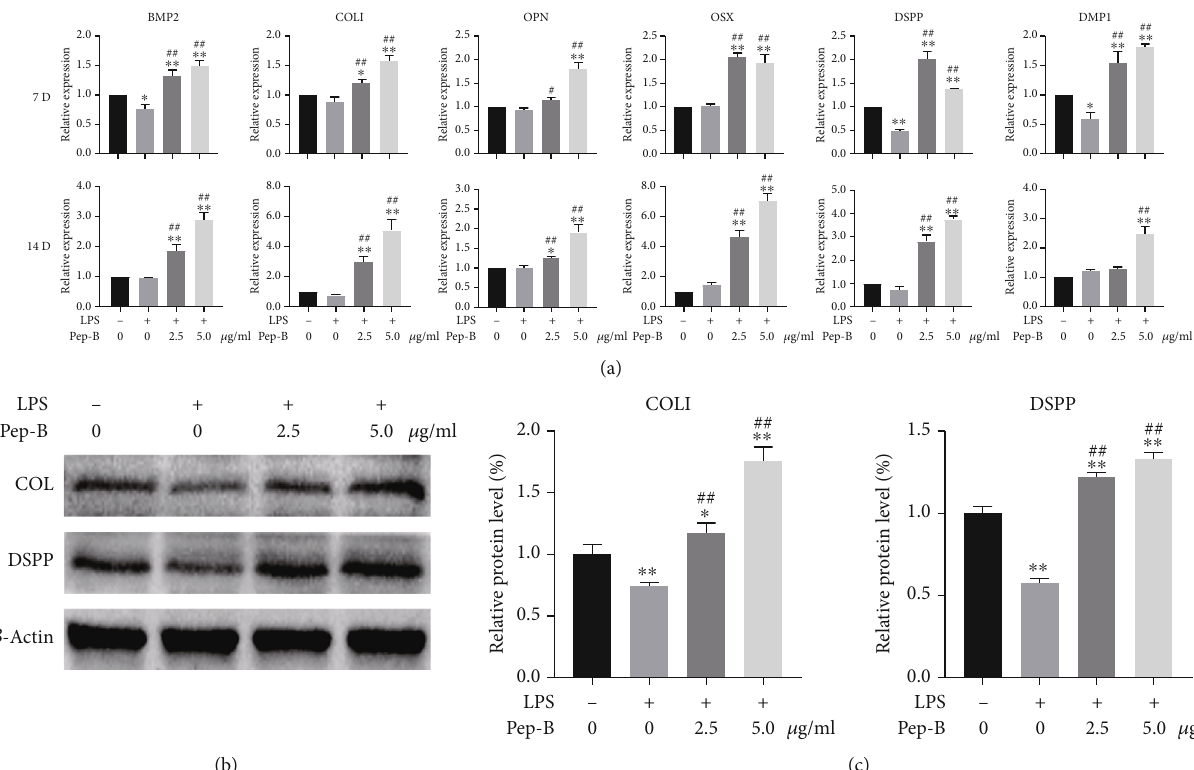
Figure 5: E ff ects of Pep-B on the expression of osteo-/odontoblast genes in LPS-induced hDPSCs. (a) The mRNA expression of BMP2, COL І , OPN, OSX, DSPP, and DMP1 was detected by qRT-PCR at 7 and 14 days. (b) The protein expression of COL І and DSPP was examined by western blot at 14 days. (c) The quanti fi cation of the western blot was determined by densitometry using ImageJ software. ∗ , # P < 0 : 05 , ∗∗ , ## P < 0 : 01 , ∗ represents comparison with the control group, # represents comparison with the LPS